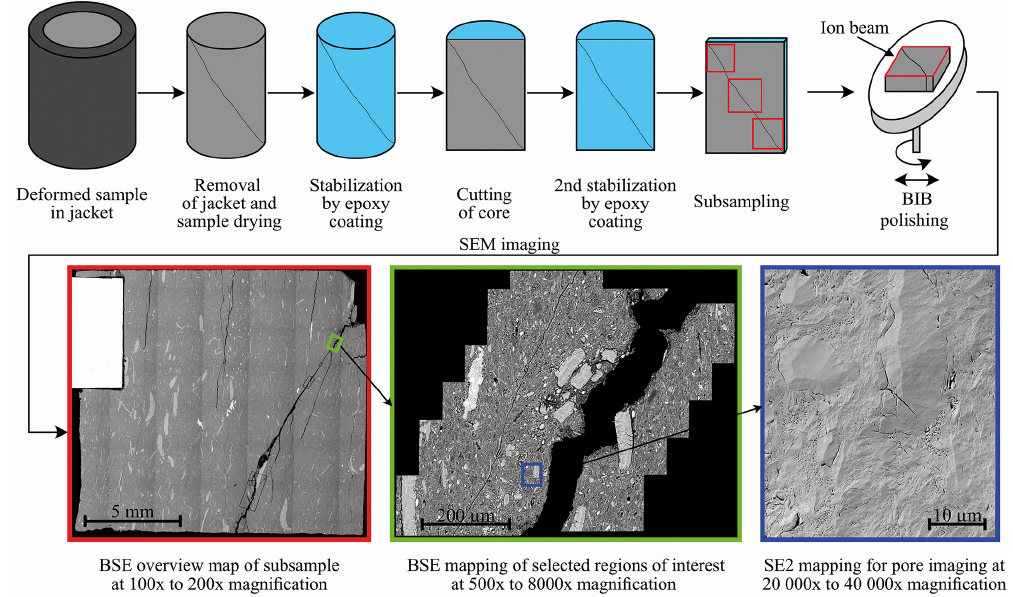
Figure 2. Procedure of sample preparation and workflow for microstructural analysis including the twofold stabilisation the broad ion-beam polishing and the imaging strategy.